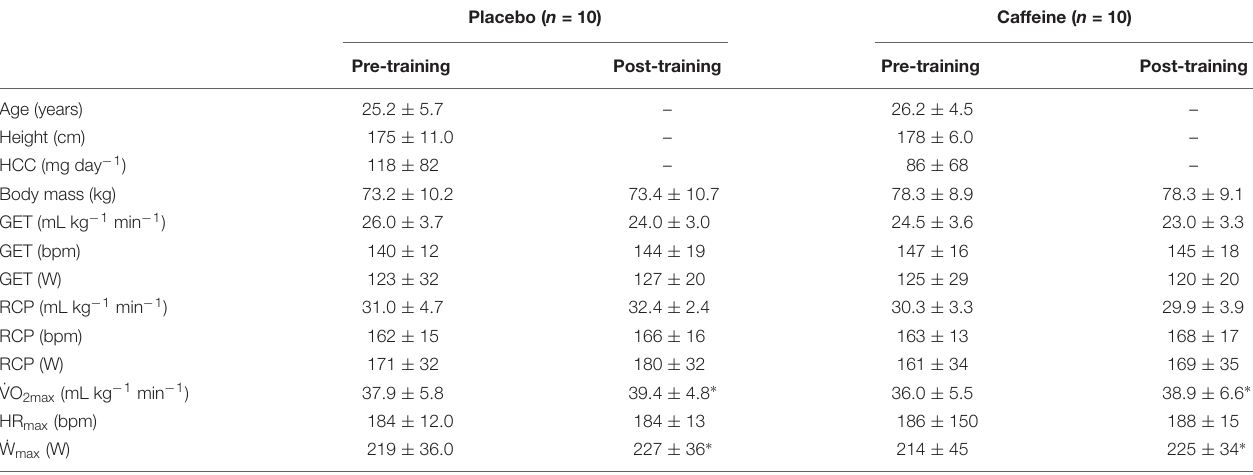
TABLE 1 | Main characteristics of the participants and physiological parameters identified during an incremental test pre- and post-training.